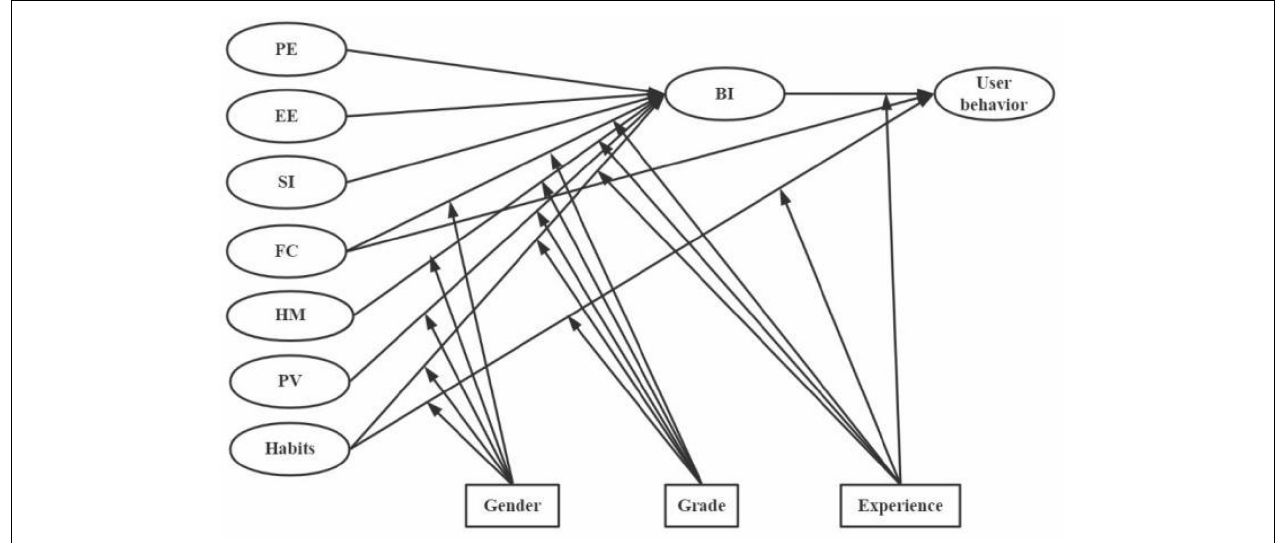
FIGURE 1 | The UTAUT2